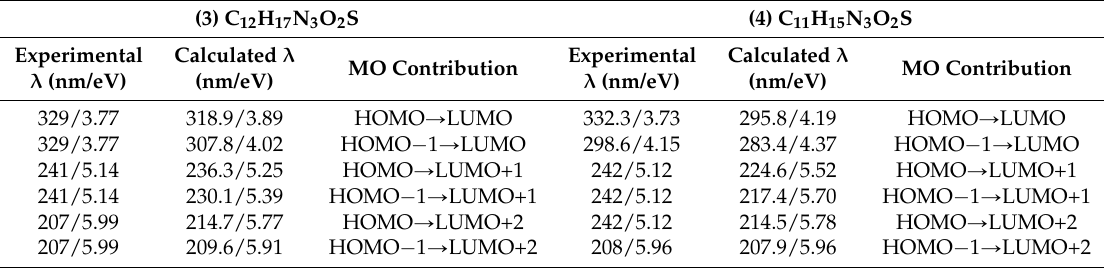
Figure 8. Calculated frontier molecular orbitals for C 12 H 17 N 3 O 2 S ( 3 ) and C 11 H 15 N 3 O 2 S ( 4 ). Table 8. Experimental and calculated energy of molecular orbitals of ( 3 ) and ( 4 ) and associated transitions. (3) C 12 H 17 N 3 O 2